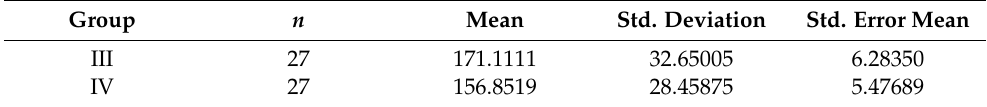
Table 11. Mean results for emotional intelligence quotient for Groups III and IV post-test